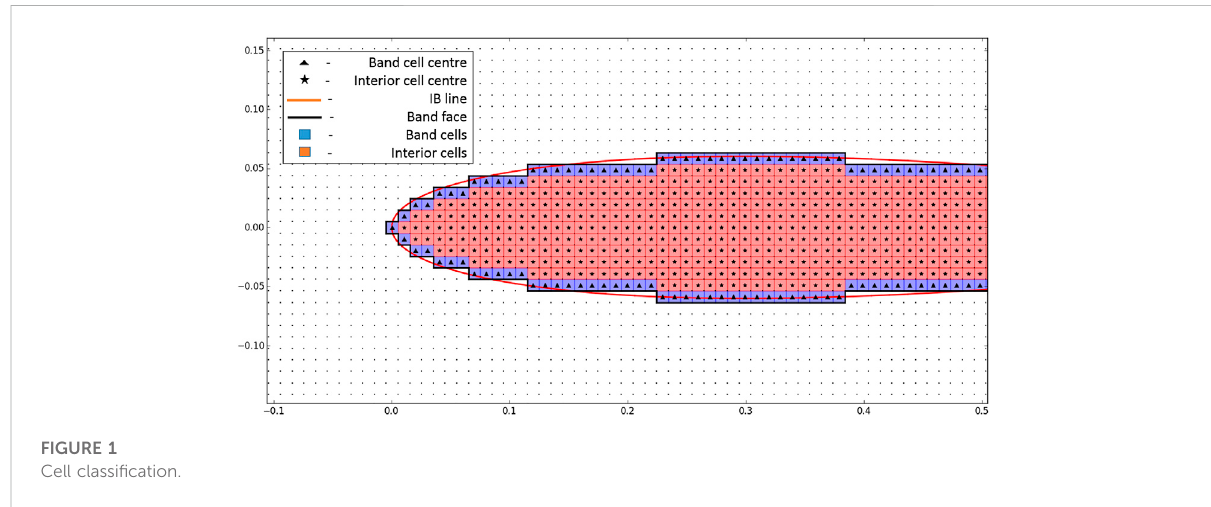
FIGURE 1 Cell classi fi